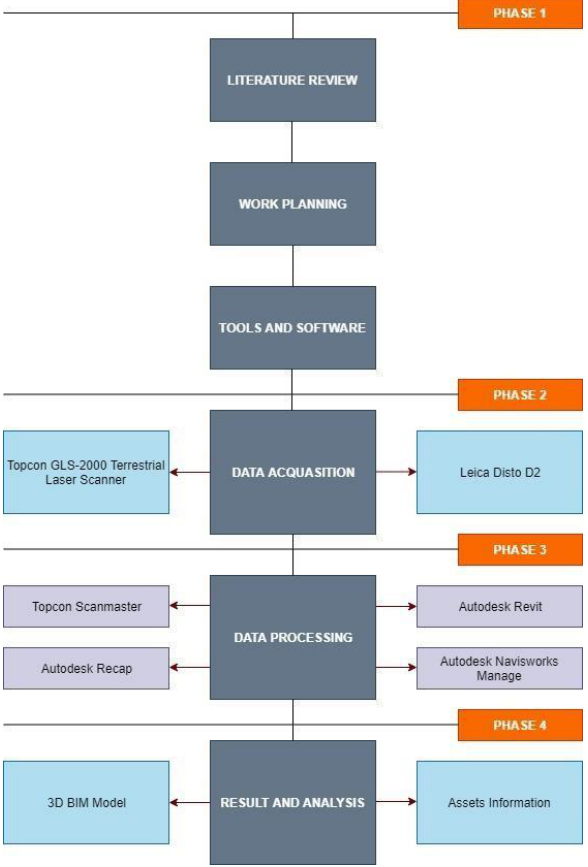
Figure 1: Methodology of